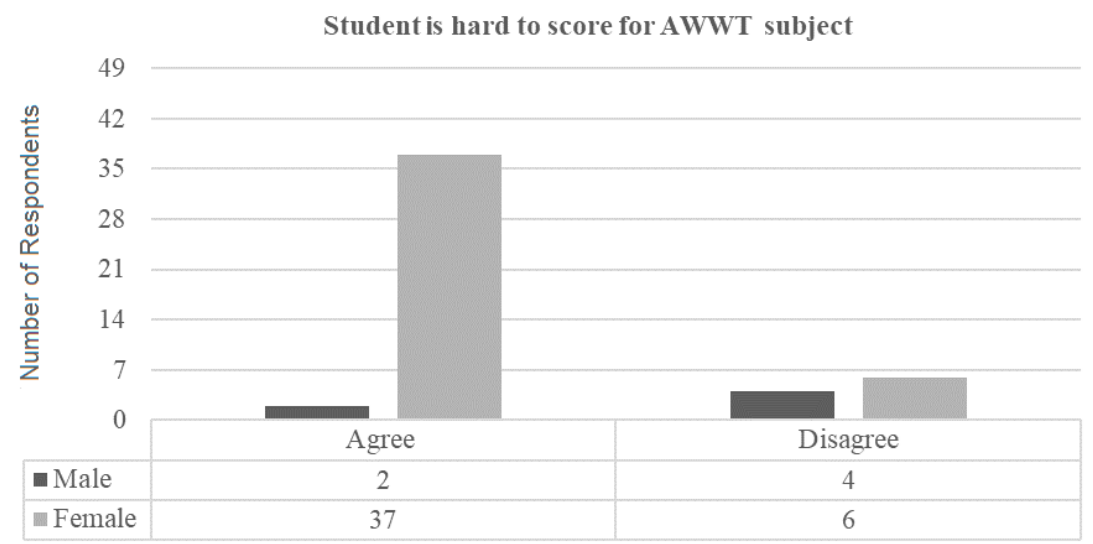
Figure 4. The perception of respondents towards the difficulty of the subject.